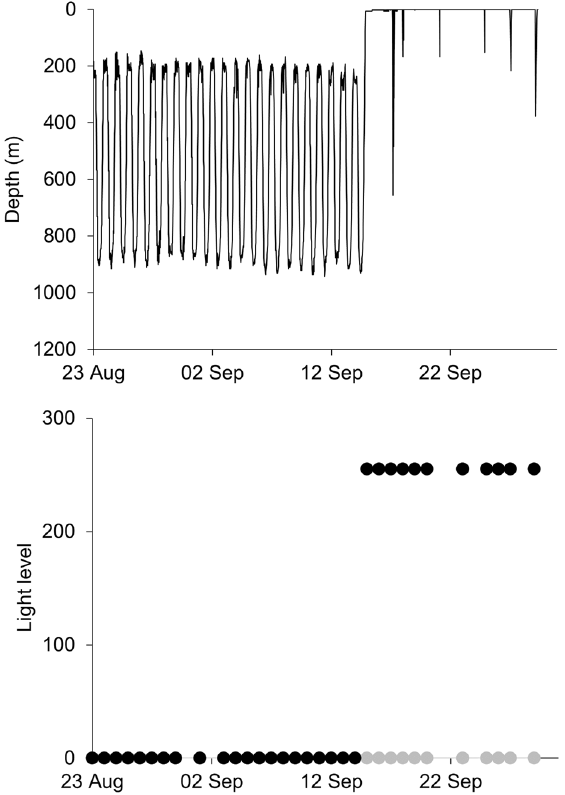
Figure 6. Example of a short-finned eel (179358) displaying regular DVM behaviour, followed by a rapid surface ascent and irregular dives from the surface. Circles denote minimum (grey circle) and maximum (black circle) light level recorded.